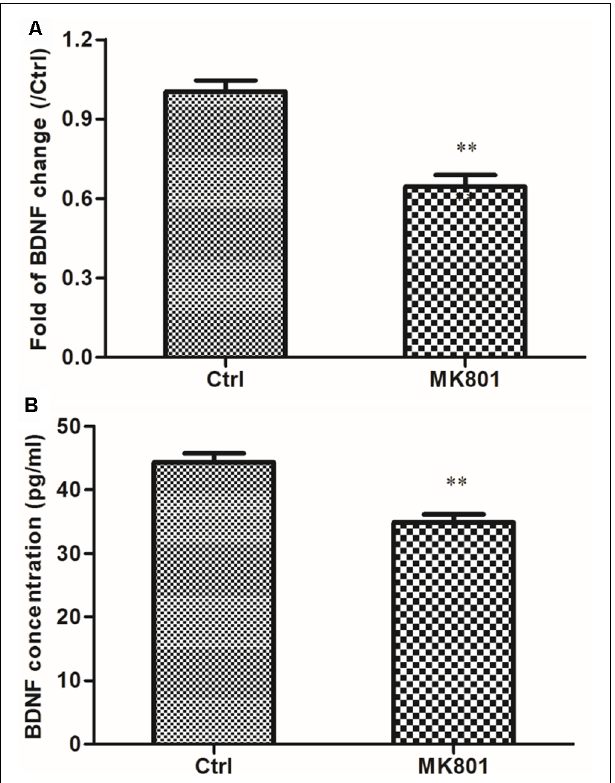
FIGURE 1 | MK-801 suppresses brain-derived neurotrophic factor (BDNF) mRNA expression and protein secretion in primary cultured hippocampal neurons. (A,B) Hippocampal neurons were cultured in the presence or absence of 20 µ M MK-801 for 24 h and BDNF mRNA and protein levels in cell lysates and culture supernatant were measured by quantitative real-time (qRT-PCR; A ) and enzyme-linked immunosorbent assay (ELISA; B ), respectively. Densitometric values are expressed as mean ± SEM of three independent experiments. ∗∗ P < 0.01 vs. control group (Student’s t